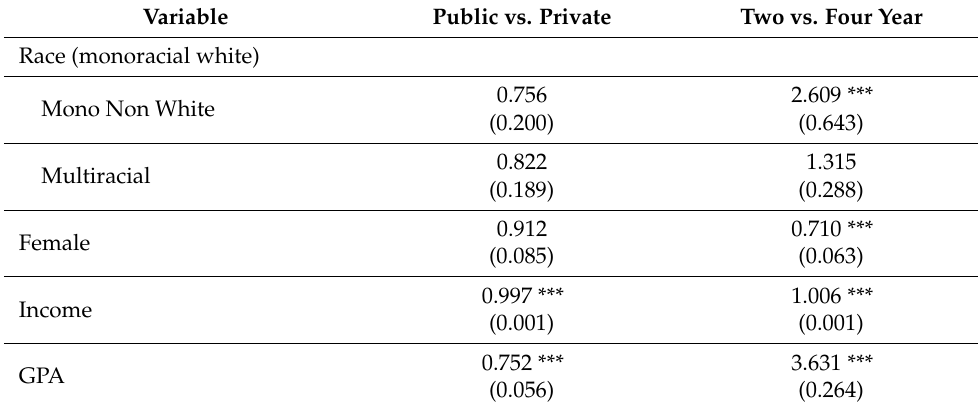
Table A4. Logistic Regression of School